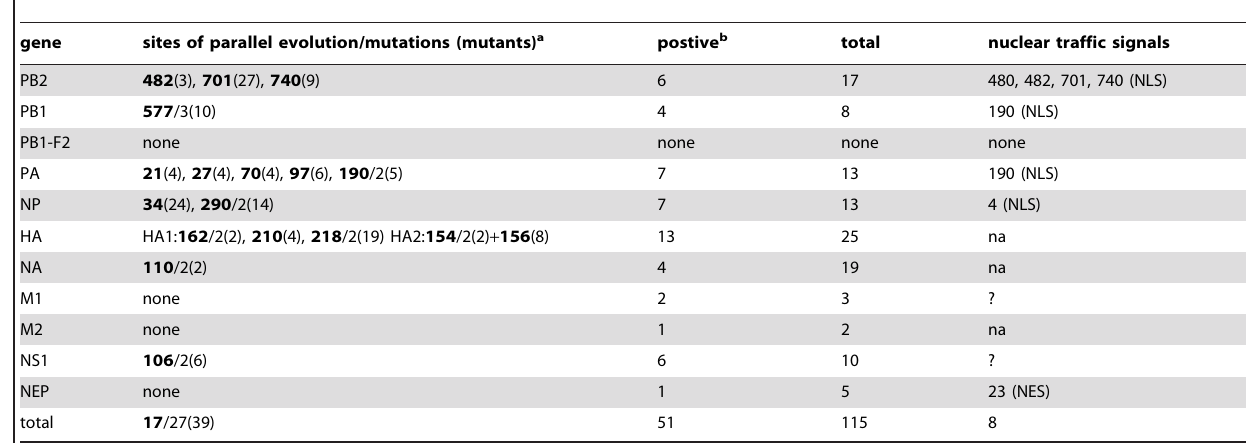
Table 4. Sites of parallel, positive and nuclear trafficking signal mouse adapted mutations.